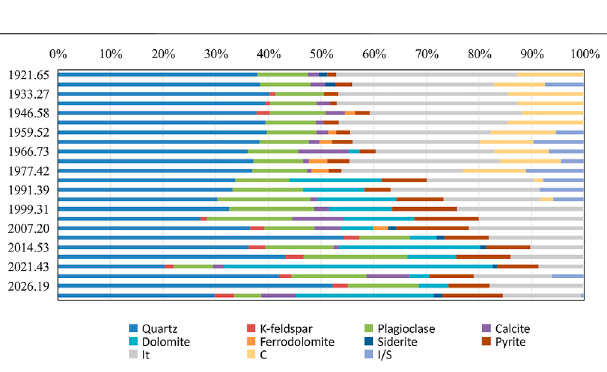
FIGURE 5 | The mineral composition of the Niutitang shale of Well